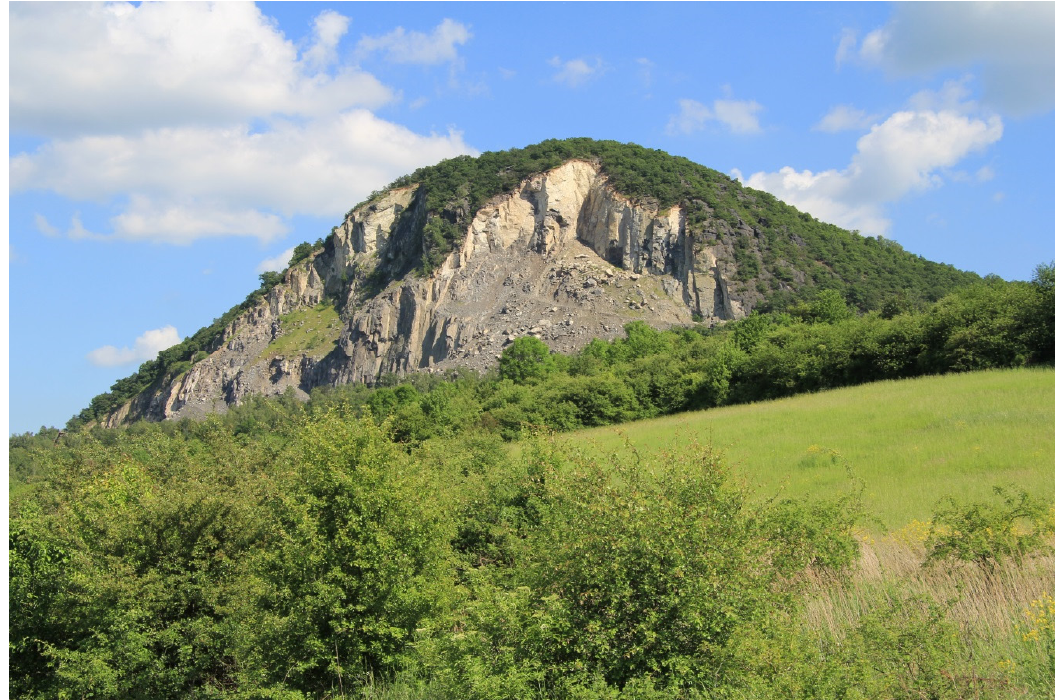
Figure 9. Želenice-Želenický vrch with nepheline phonolite deposit and quarry. Photo: Jaromír Starý, 2014.